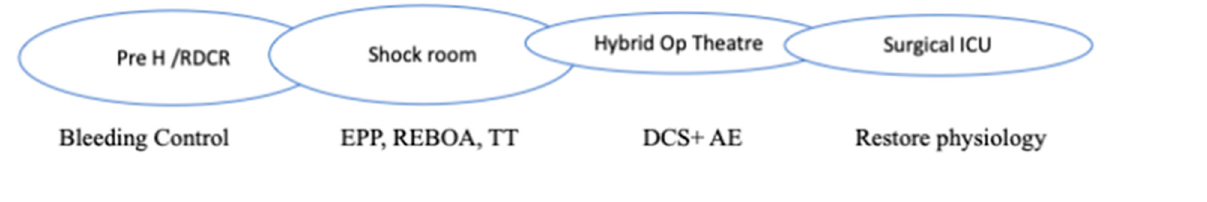
Figure 1. Chain of Trauma Survival.